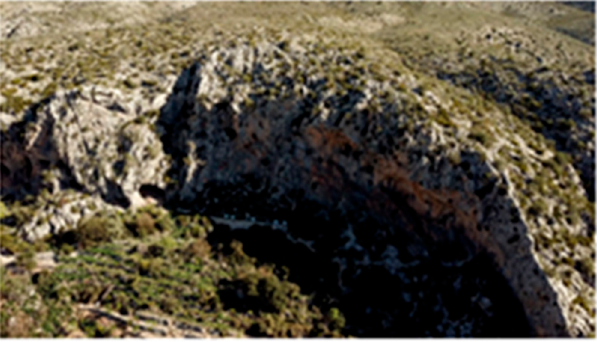
Figure 6. Semi-circular shape of Pla de Petracos’ rocky shelter. Photography: Jorge Molina Lamothe. Source: (Soler Díaz and García 2020).